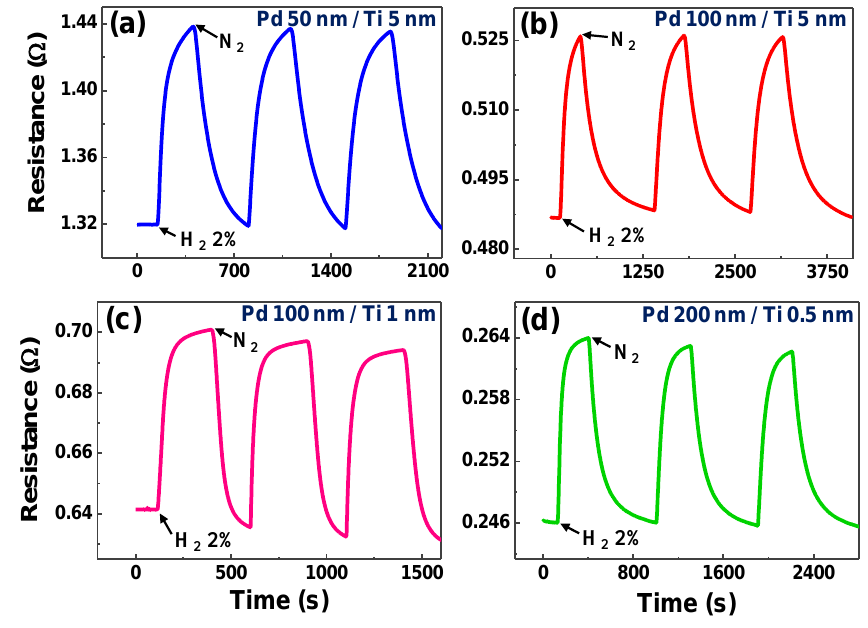
Figure 6. The real-time electrical responses of Pd films on a Ti buffer layer with different combinations of Pd and Ti layer thicknesses: (a) 50(Pd)/5(Ti) nm, (b) 100/5 nm, (c) 100/1 nm, and (d) 200/0.5 nm. Measurements were performed at room temperature, using 2% H . Data reproduced from Kim et al . 2